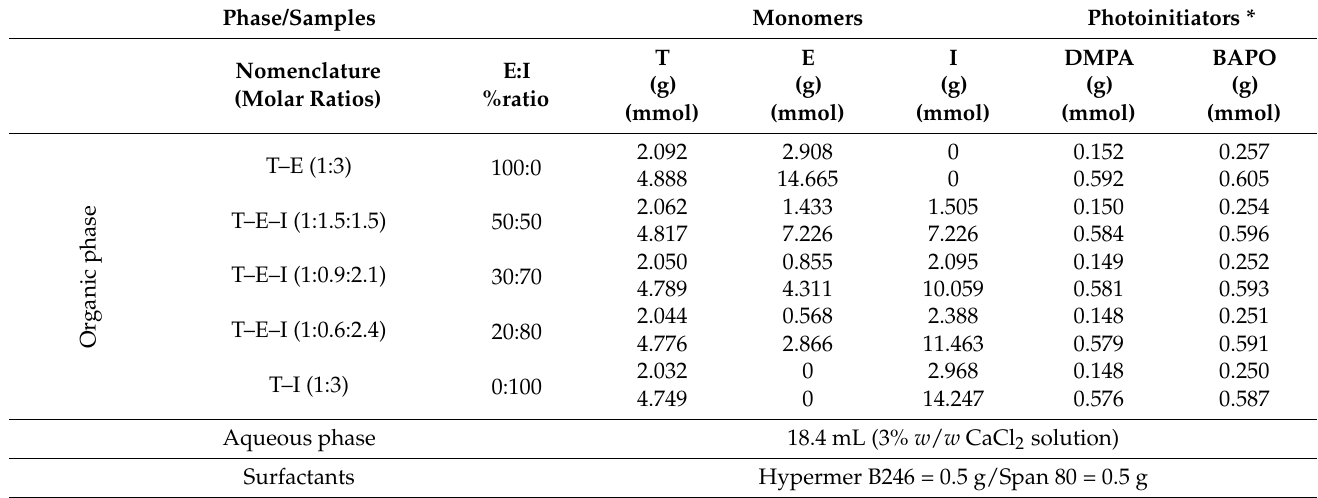
Table 1. Composition of the formulations for each studied photocurable HIPE.